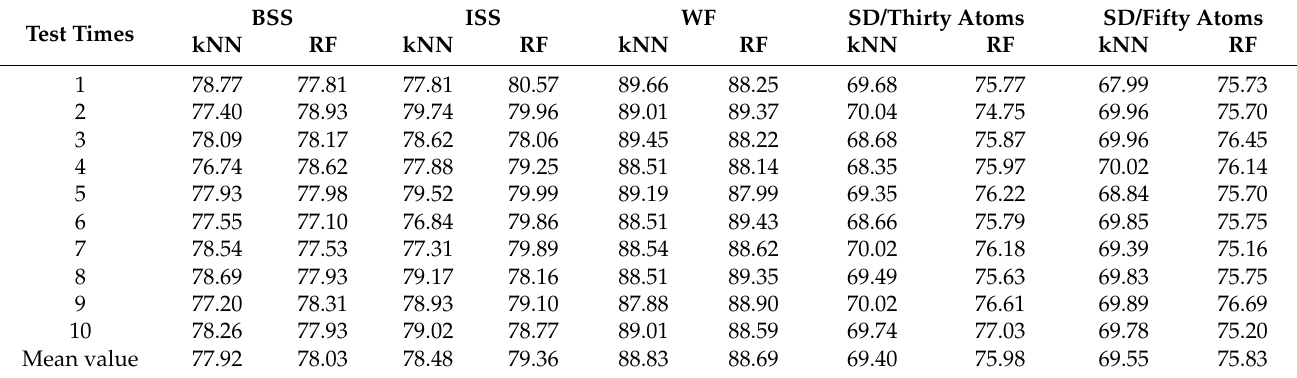
Table 4. Specific descriptions of the prediction results achieved by the kNN classifier on the five data